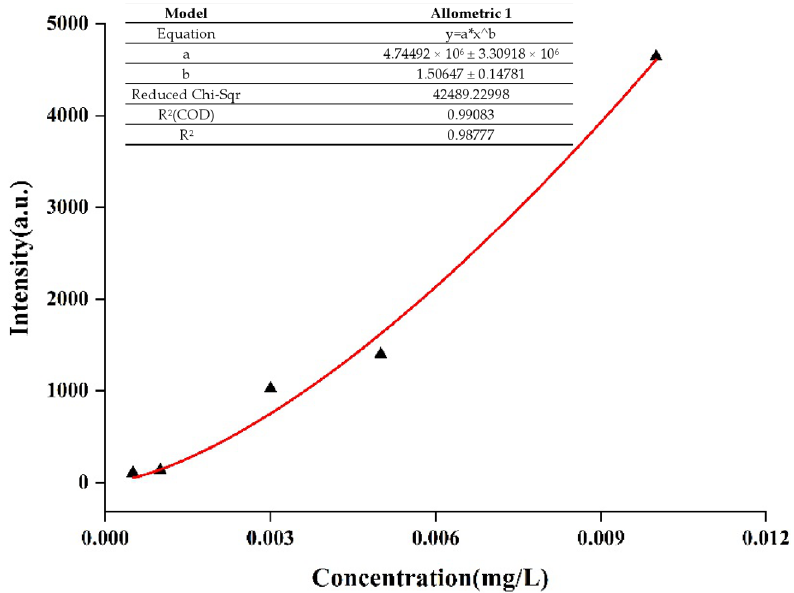
Figure 11. Fitting analysis of SERS test results of different concentrations of aflatoxin B 1 methanol solution.